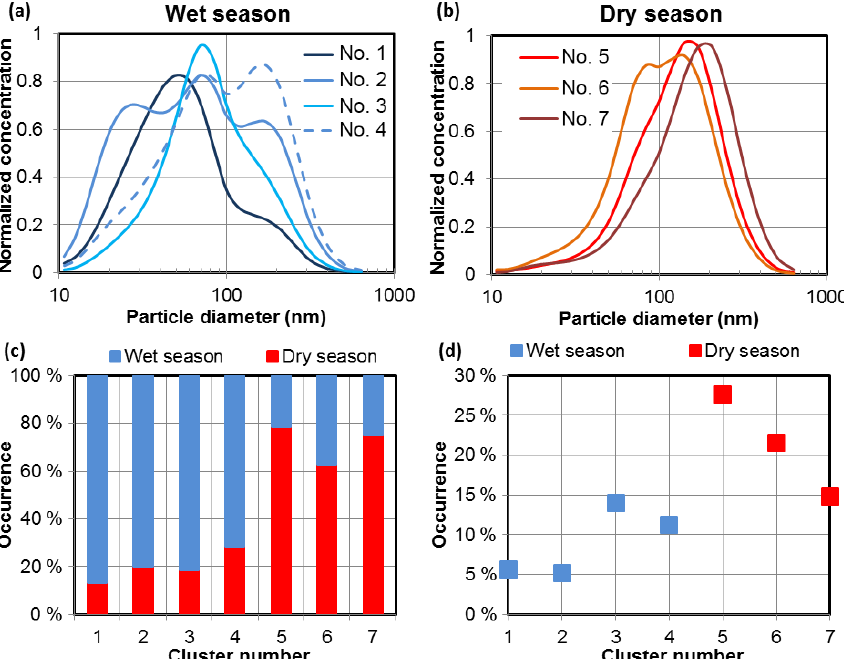
Figure 5. Normalized particle number size distribution cluster centroids occurring in the wet season (a) and dry season (b) . The percentage of the occurrence of each cluster in each season (c) , and the percentage of the size distribution samples included in each cluster (d)